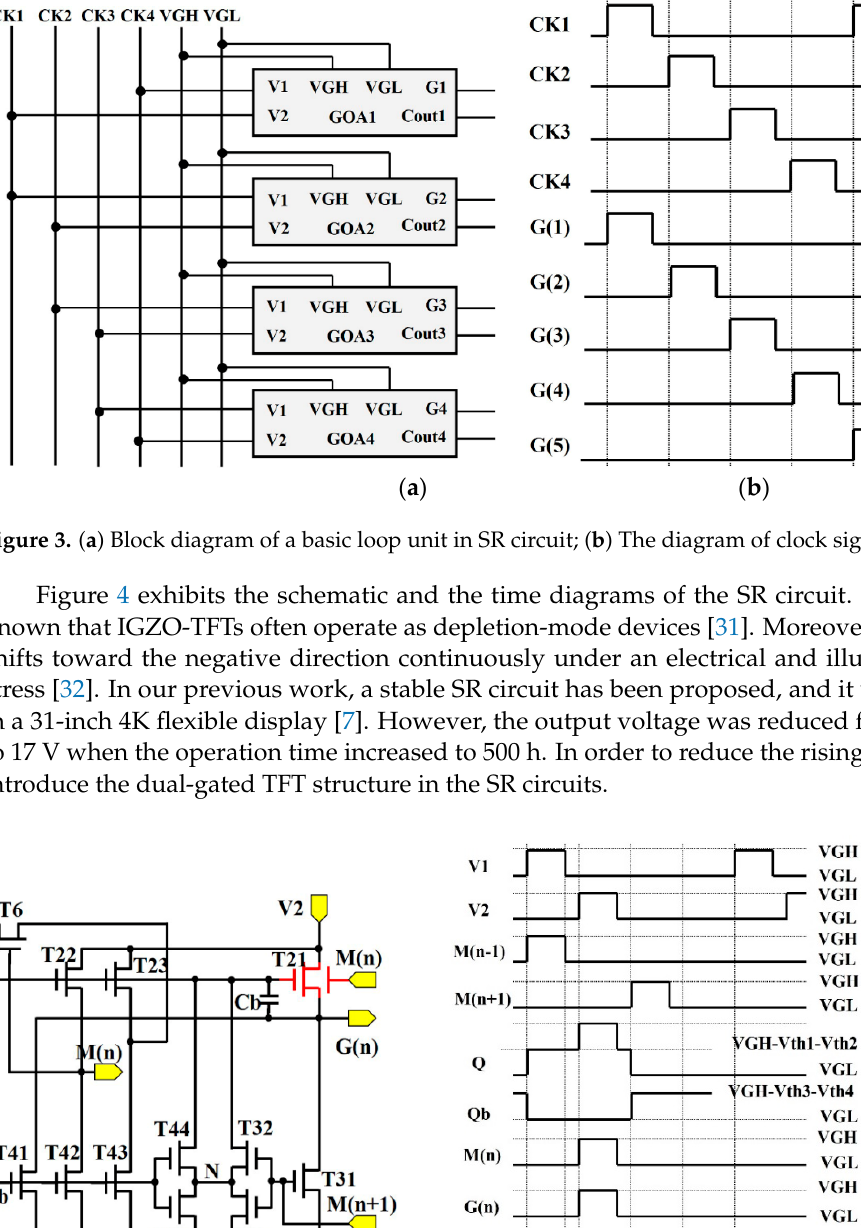
Figure 3. ( a ) Block diagram of a basic loop unit in SR circuit; ( b ) The diagram of clock signals.